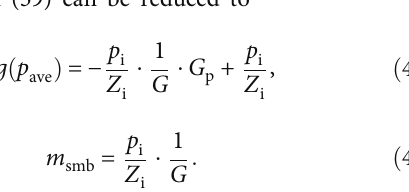
Figure 7: The relation curves of pseudopressure ( p